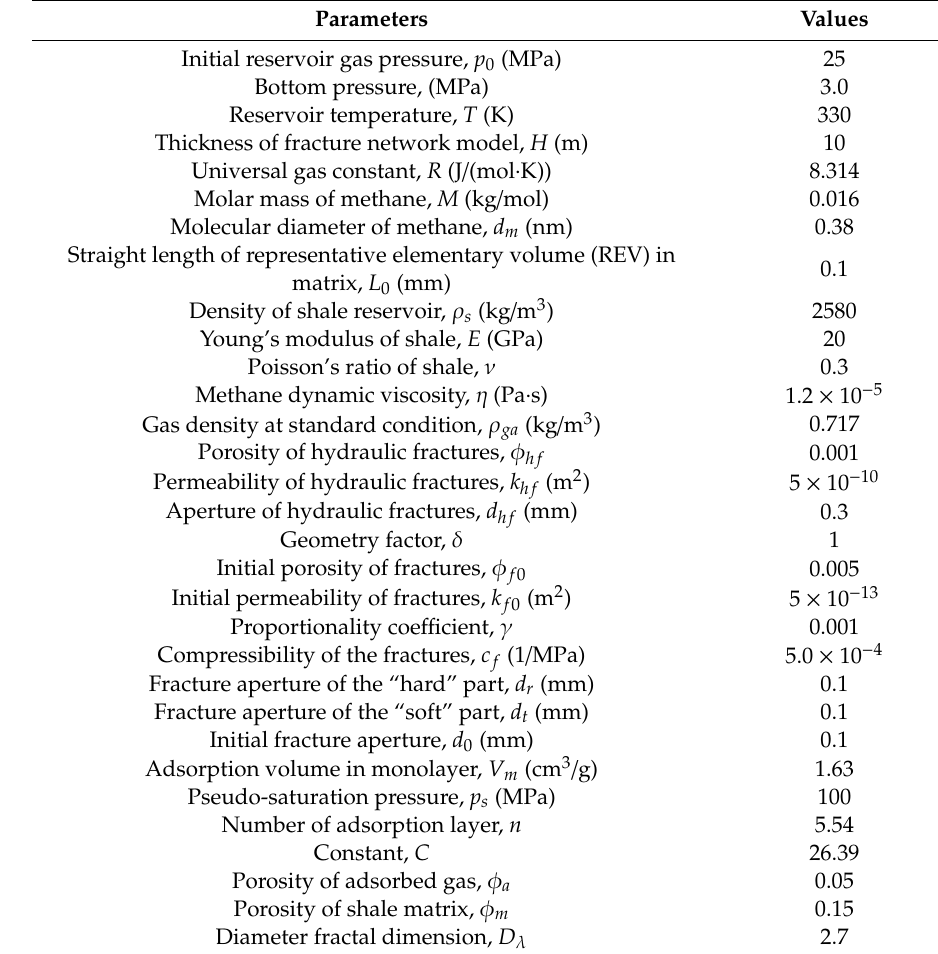
Table 2. All parameters used in numerical